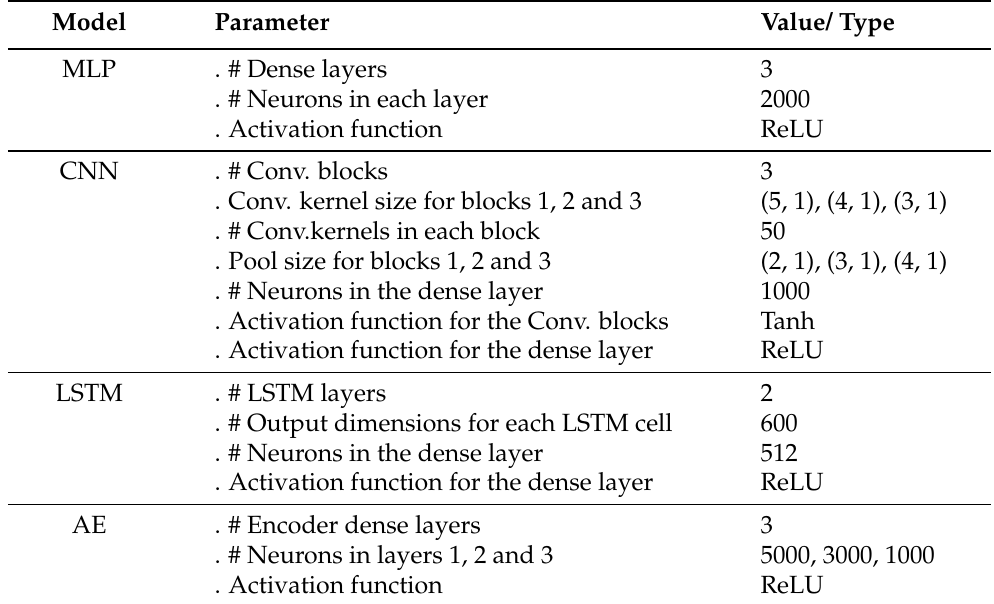
Table 3. Hyper-parameters of the ANN models on the SHRP2 data set.